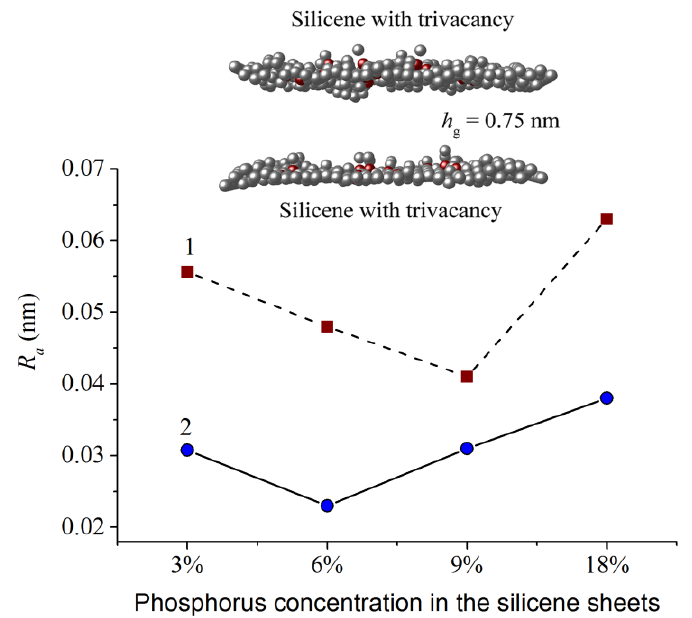
Figure 15. Roughness of the top (1) and bottom (2) silicene sheets of the system “P-doped silicene channel located on the 5% N-doped graphite substrate” with different phosphorus concentrations; insert shows zx -projection of the silicene channel with the 9% phosphorus concentration. Reprinted with permission from Ref. [11]. 2021, Elsevier.